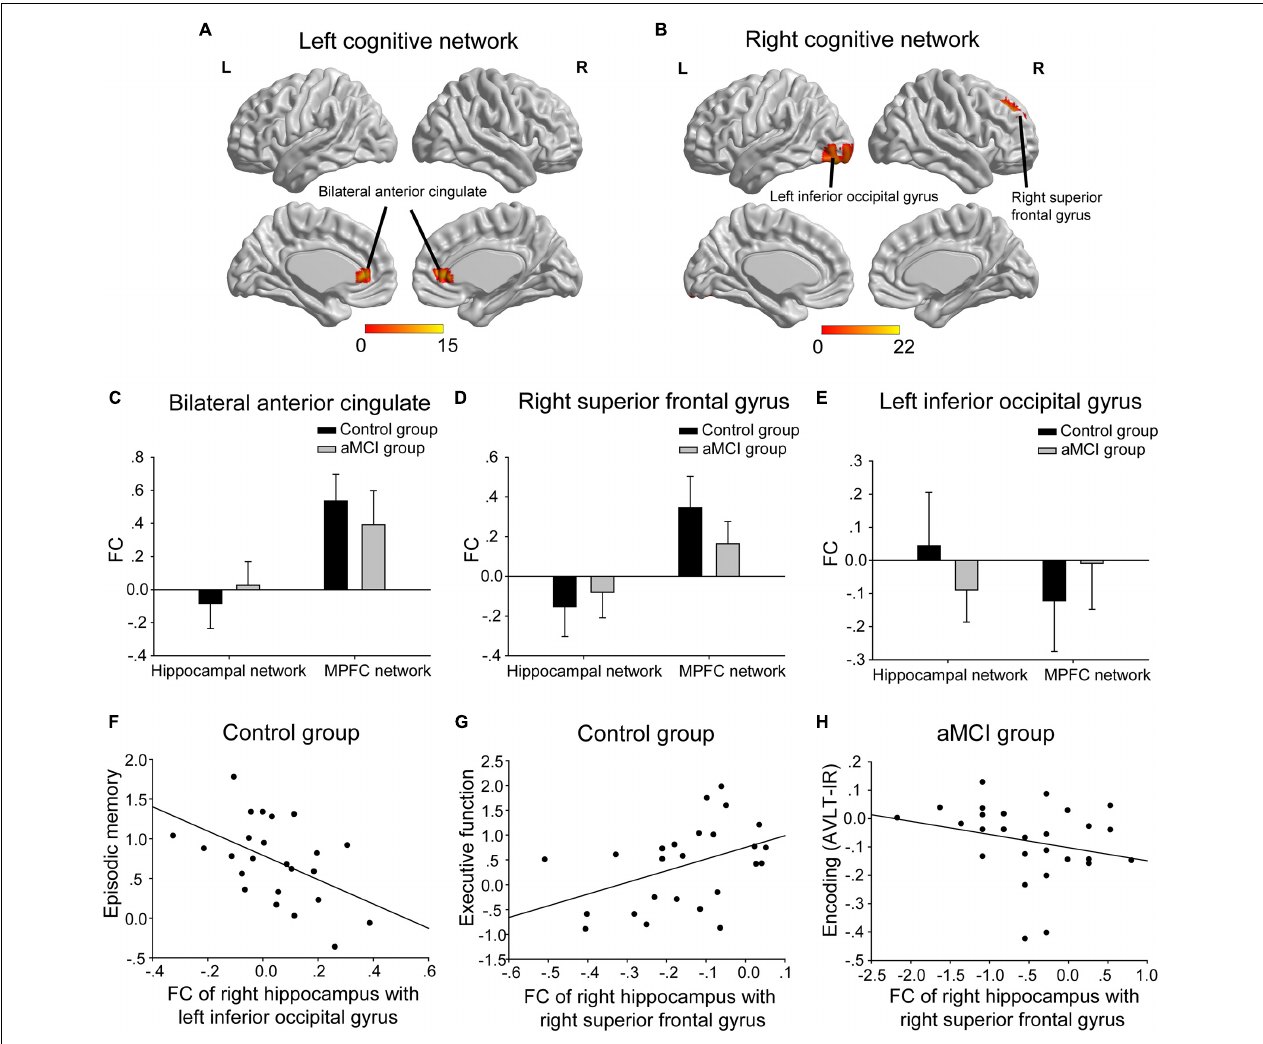
FIGURE 3 | The interactions of groups-by-networks. (A) The interactions of the group-by-left cognitive networks were mainly in bilateral anterior cingulate. (B) The interactions of the group-by-right cognitive networks were mainly in the right superior frontal gyrus and the left inferior occipital gyrus. The statistical thresholds were set at a corrected P < 0.01, which was determined by a Monte Carlo simulation. The color bars are presented with F values. (C,D) In both bilateral anterior cingulate and the right superior frontal gyrus, the FC of the hippocampal network was higher in the aMCI group than in the control group, whereas the FC of the MPFC network was lower in the aMCI group than in the control group. (E) In the left inferior occipital gyrus, the FC of the hippocampal network was lower in the aMCI group than in the control group, whereas the FC of the MPFC network was higher in the aMCI group than in the control group. (F) The FC of the right hippocampus with the left inferior occipital gyrus was negatively associated with episodic memory scales in the control group. (G) The FC of the right hippocampus with the right superior frontal gyrus was positively associated with executive function scales in the control group. (H) The FC of the right hippocampus with the right superior frontal gyrus was negatively associated with encoding (i.e., AVLT-IR) scales in the aMCI group. The above FC value in each significant cluster was the averaged FC strength in each cluster. L, left; R, right; FC, functional connectivity; AVLT-IR, auditory verbal learning test-immediate